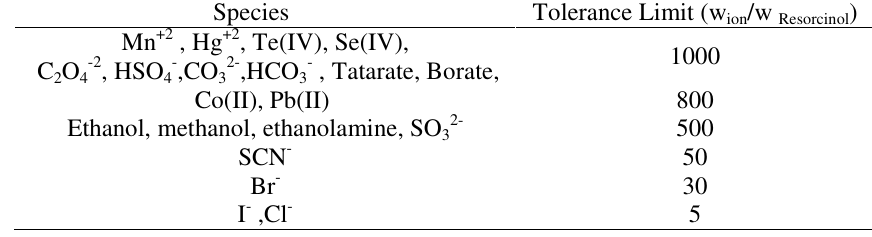
Table 1. Effect of foreign ions on the determination of 0.1 µg/mL resorcinol.